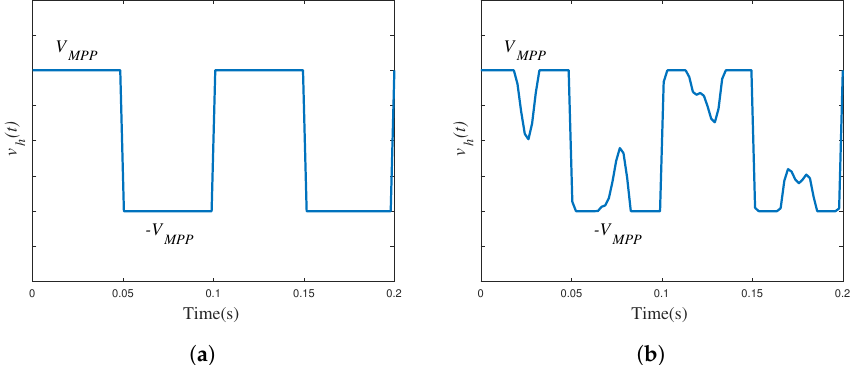
Figure 11. Reflection of the PMIC input voltage into the harvester AC terminals: ( a ) Single-frequency excitation; ( b ) Multiple-frequency